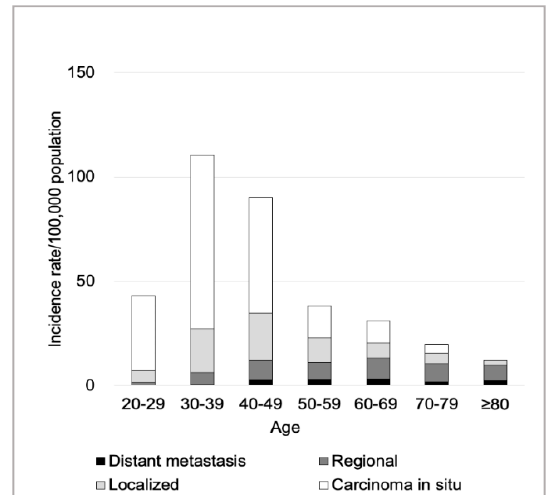
Figure 1. Age-specific cervical cancer incidence for each cancer stage between 2009 and 2013. The incidence of carcinoma in situ (CIS) and early-stage cancer was highest in women aged 30–39 years. The age-specific incidences of regional and distant metastatic cancers/100,000 population in their 40s, 50s, 60s, 70s, and ≥ 80s were, respectively, as follows: regional cancer, 9.2, 8.1, 10.0, 8.7, and 7.2; distant metastatic cancer, 2.9, 2.9, 3.2, 1.9, and 2.3.